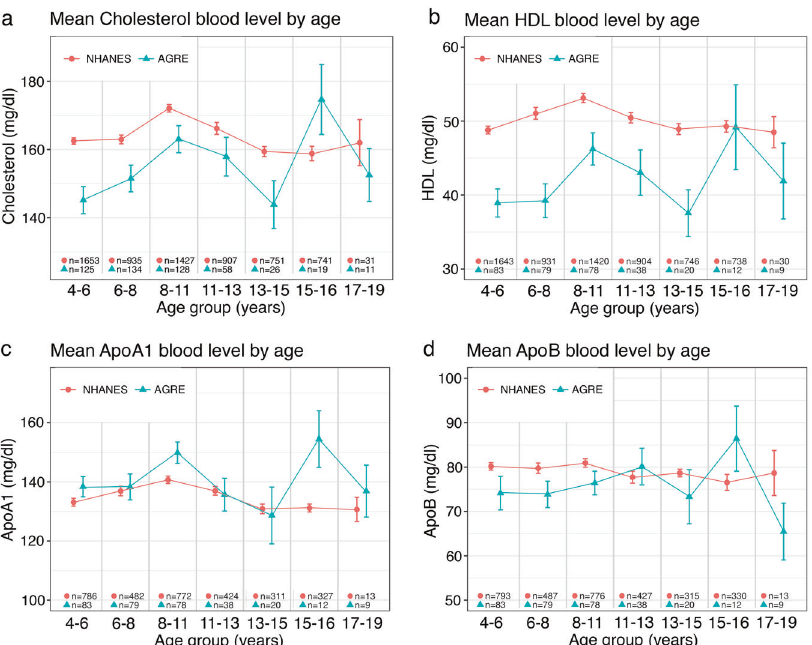
Fig. 3 Distributions of NHANES-III and AGRE cholesterol and lipoprotein levels by age segments. a The distributions of cholesterol (CHL), HDL, apolipoprotein A1 (ApoA1), and ApoB by age segments, 4.0 – 18.9 years, between National Health and Nutrition Examination Survey III (NHANES-III) AGRE subjects: CHL 6445 and 500 AGRE subjects. b HDL 6412 NHANES-III and 312 AGRE subjects. c ApoA1 3115 NHANES-III and 312 AGRE subjects. d ApoB 3141 NHANES-III and 312 AGRE subjects. Center point is mean value, error bars extend one standard error (SE) of the mean in each direction. Mean and SE for NHANES-III group are calculated using survey-weighted methods.